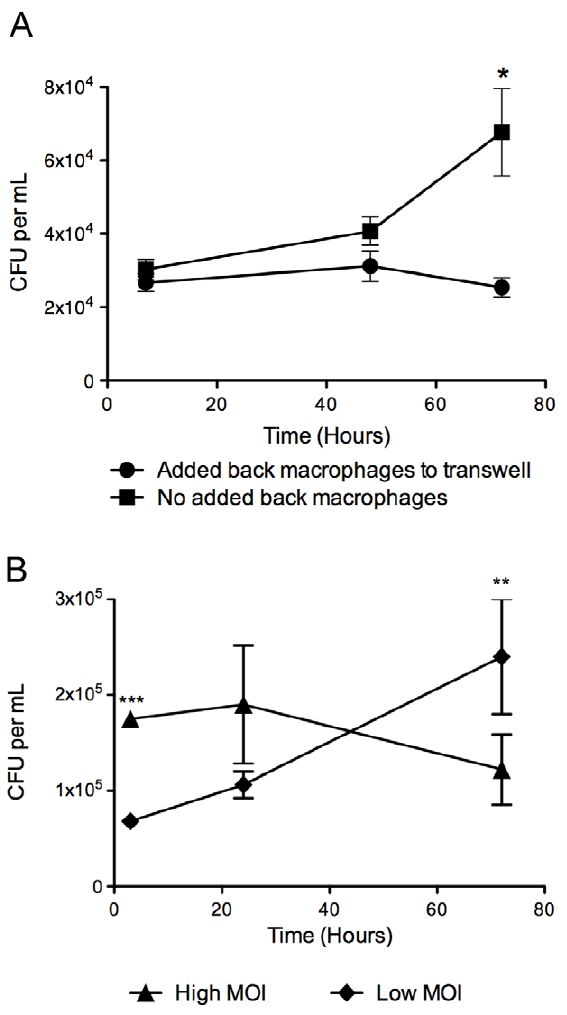
Figure 2. Interactions between infected and naı¨ve macrophag- es results in the production of a soluble factor that reduces M.tb viability. ( A ) Macrophages infected with M.tb Erdman (MOI 50) were cultured alone or in the presence of uninfected macrophages separated by transwell polycarbonate membranes. Results are ex- pressed as mean CFU per mL 6 SD at the indicated time points. *, p =0.018 comparing co-cultures of M.tb -infected plus uninfected macrophages to infected macrophages alone at 72 h. ( B ) Filter- sterilized supernatant from macrophage co-cultures was added to wells contained isolated, infected macrophages alone. Transfer of co- culture supernatant reduced M.tb viability demonstrating that the factor responsible for the effect is soluble. *, p , 0.0001; **, p =0.002.